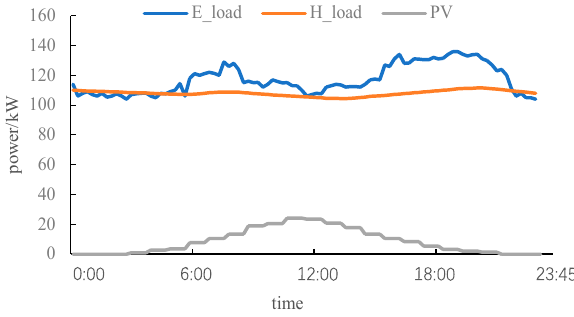
Figure 3. Thermoelectric load and photovoltaic output power in summer.